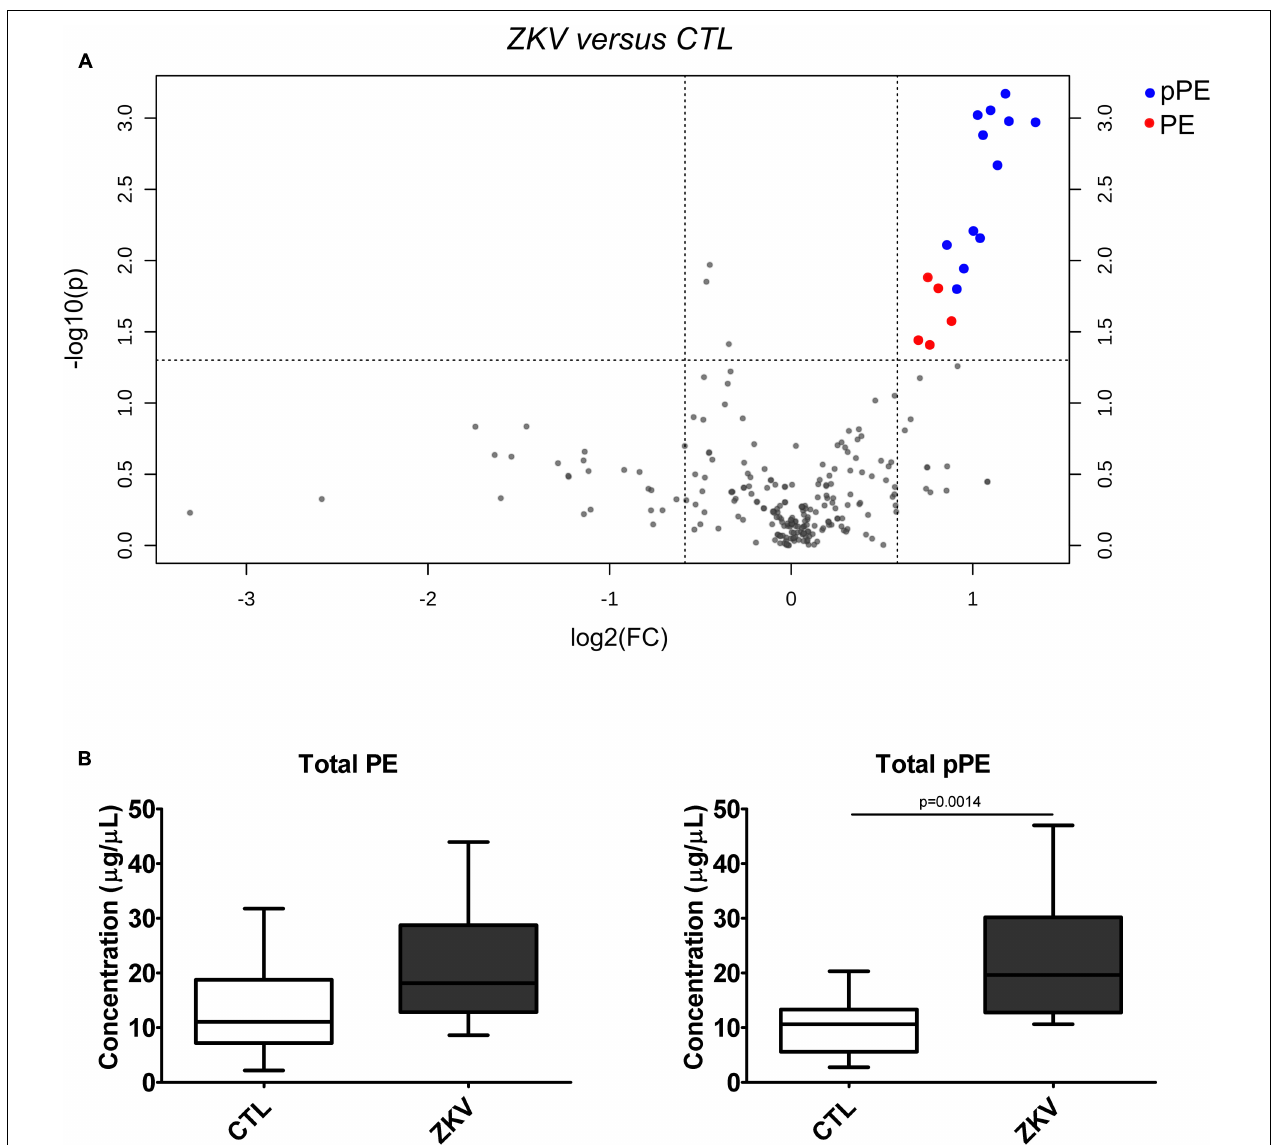
FIGURE 2 | Volcano plot (A) of the lipid molecular species altered in ZIKV patients vs. control group. The log 2 fold change (FC) of ZIKV vs. CTL group was plotted against the -log 10 p -value. Statistical significance was evaluated by t -test ( p -value < 0.05) and FC threshold was set to higher than 1.5. Dots in red and blue represent significantly altered pPE and PE species, respectively. Total PE and pPE levels in ZIKV-infected patients (B) . Data are expressed as mean ± standard error ( n = 12 for each group). Comparison between the groups was performed using t -test. A p -value < 0.05 was considered statistically significant. Total PE and pPE levels were calculated as the sum of all lipid species in each of the lipid classes. Concentration values are given in µ g lipid/ µ L of serum.